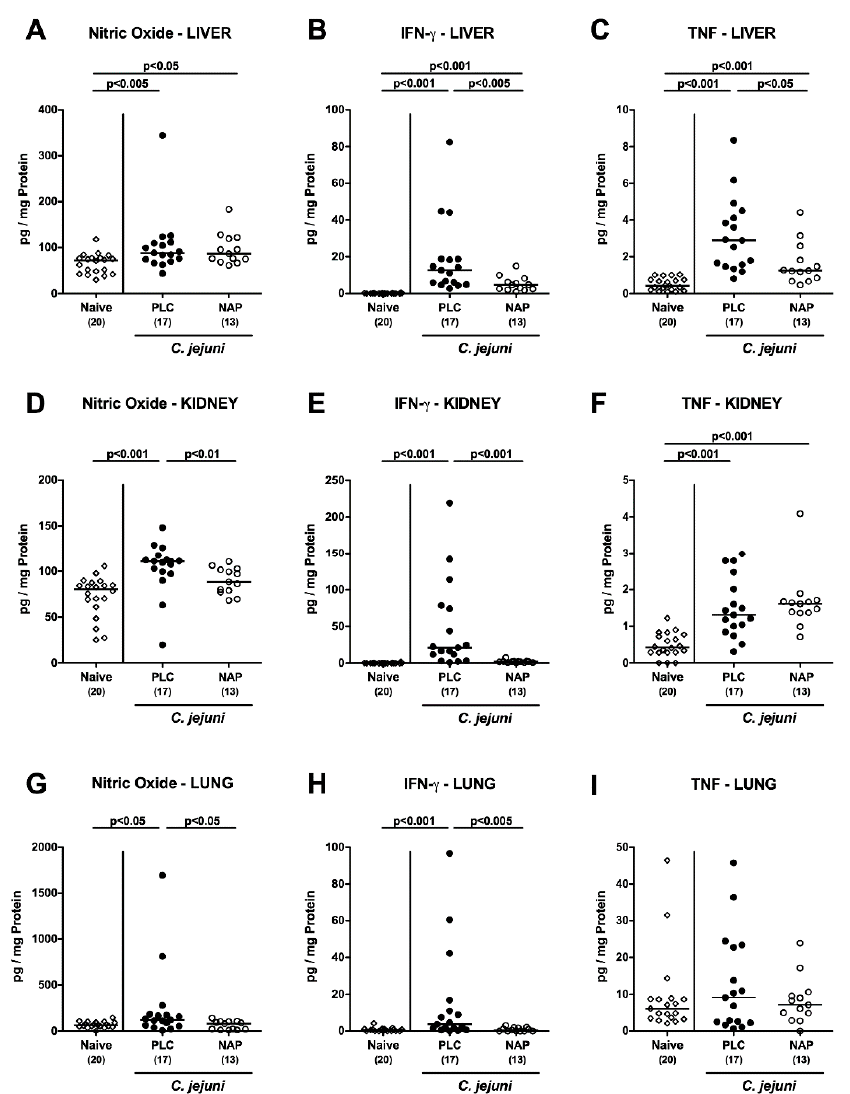
Figure 6. Extra-intestinal pro-inflammatory mediator secretion following NAP treatment of C. jejuni infected secondary abiotic IL10 − / − mice. On day (d) 0 and d1 secondary abiotic IL10 − / − mice were perorally infected with C. jejuni strain 81-176 by gavage and treated intraperitoneally with either synthetic NAP (open circles) or placebo (PLC; closed circles) from d2 until d5. On d6 post-infection, nitric oxide ( A , D , G ), IFN- γ ( B , E , H ), and TNF ( C , F , I ) concentrations were measured in ex vivo biopsies taken from liver ( A – C ), kidney ( D - F ), and lung ( G – I ). Naive mice served as negative controls (open diamonds). Medians (black bars), levels of significance ( p -values) as determined by the Kruskal–Wallis test and Dunn’s post-correction, as well as numbers of analyzed mice (in parentheses) are indicated. Data were pooled from four independent